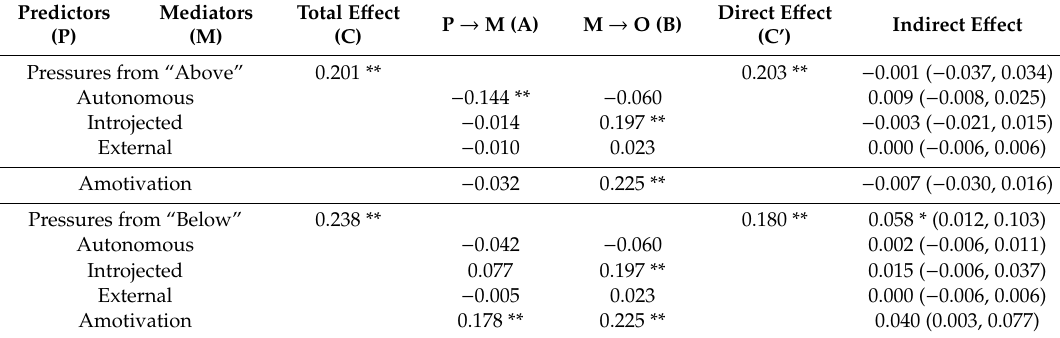
Table 2. Mediation results in controlling strategies as dependent